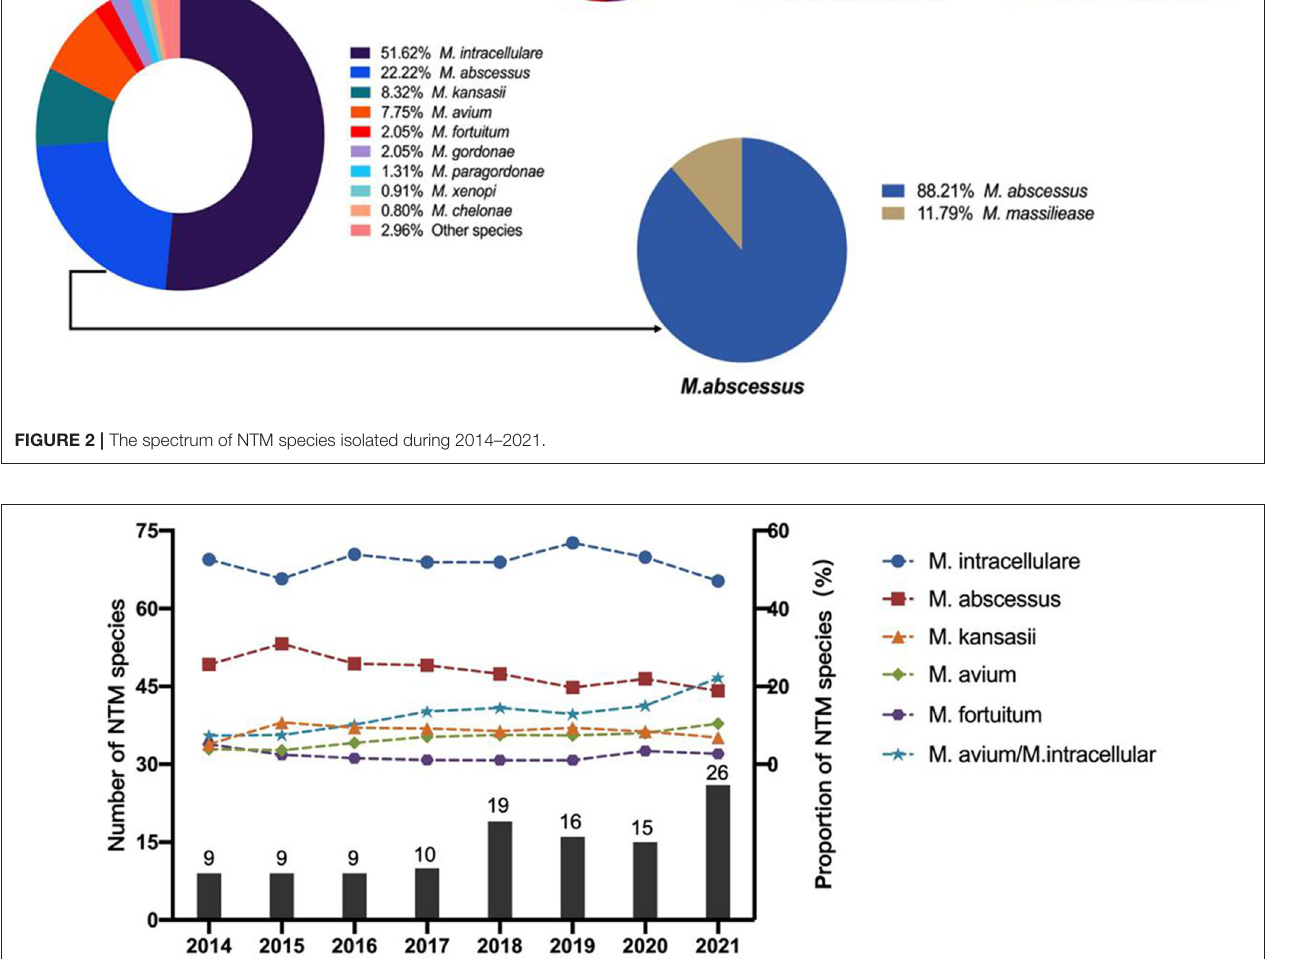
aerobic actinomycete and was a cause of opportunistic infection. Burkholderia are Gram-negative bacilli and opportunistic human pathogens (25–29). Several studies reported that Gordonia , Nocardia and Tsukamurella had also been identified in suspected Mycobacterium species isolates in China (8, 12,